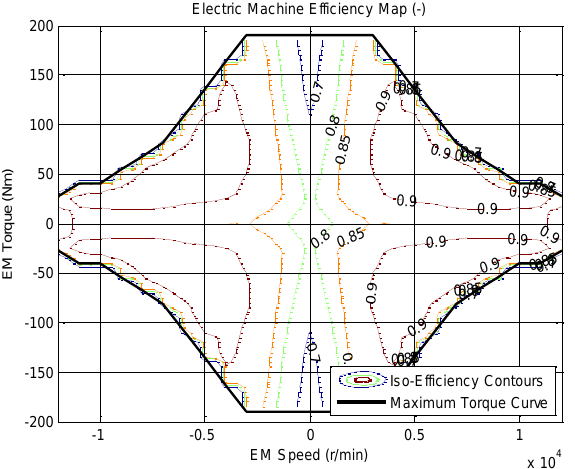
Figure 6. Motor / generator’s e ffi ciency Figure 6. Motor/generator’s efficiency chart.